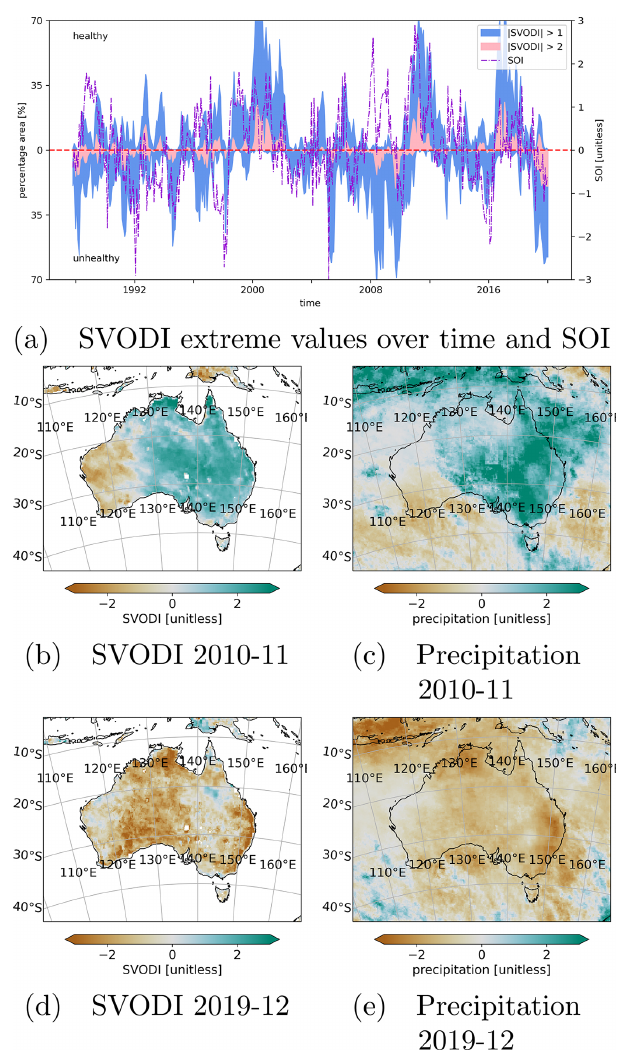
Figure 10. Percentage area of SVODI greater/smaller than 1/ − 1 and 2/ − 2 for central Australia together with the SOI (a) , SVODI (b, d) and standardized precipitation anomalies (c, e) for Novem- ber 2010 and December 2019.